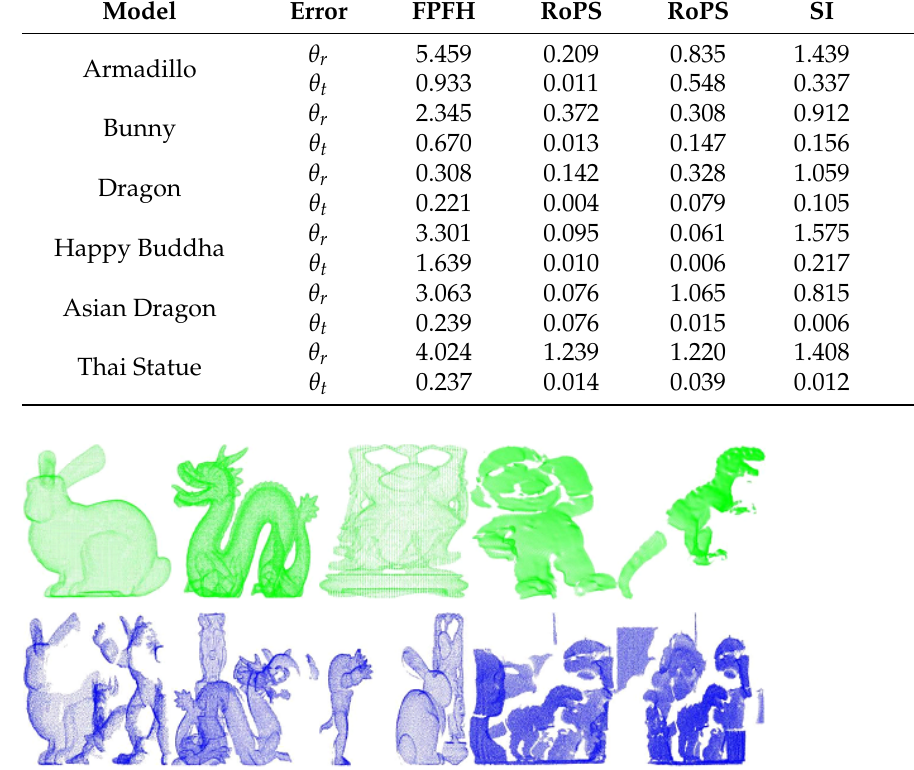
Figure 13. Point clouds that were selected in the